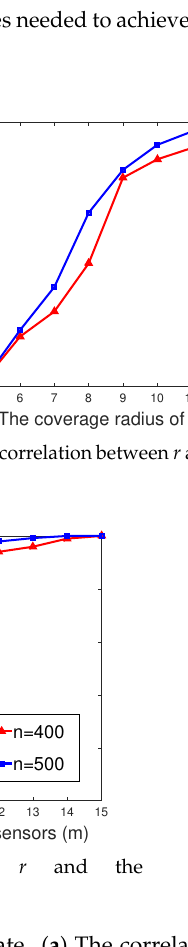
Figure 10. The correlation between r and the coverage rate. ( a ) The correlation between r and the one-coverage rate; ( b ) The correlation between r and the two-coverage rate; ( c ) The correlation between r and the three-coverage